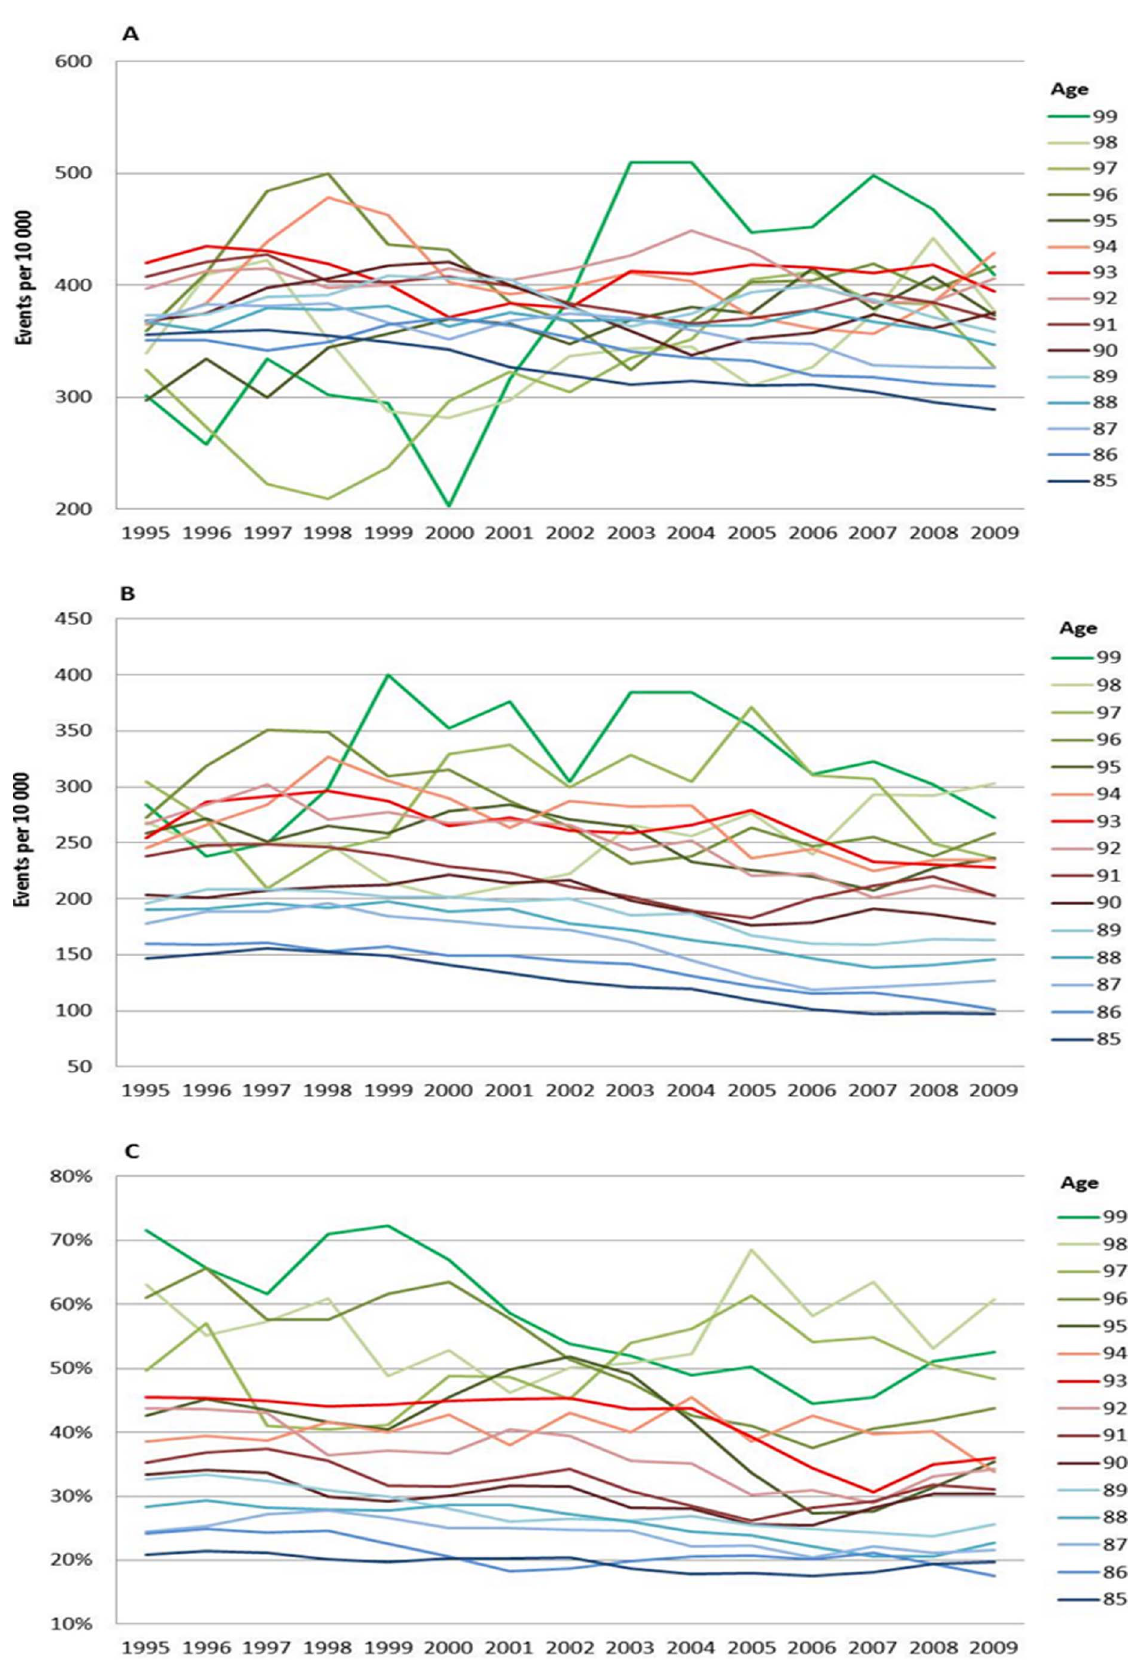
Figure 5. Stroke incidence (A), mortality (B) and case fatality (C), men. Age specific trends in stroke, men, between 1994 and 2010. One year cumulative incidence (A), overall mortality (B), and, case fatality within 28 days, percent (C). Three year moving average. doi:10.1371/journal.pone.0064928.g005 PLOS ONE |